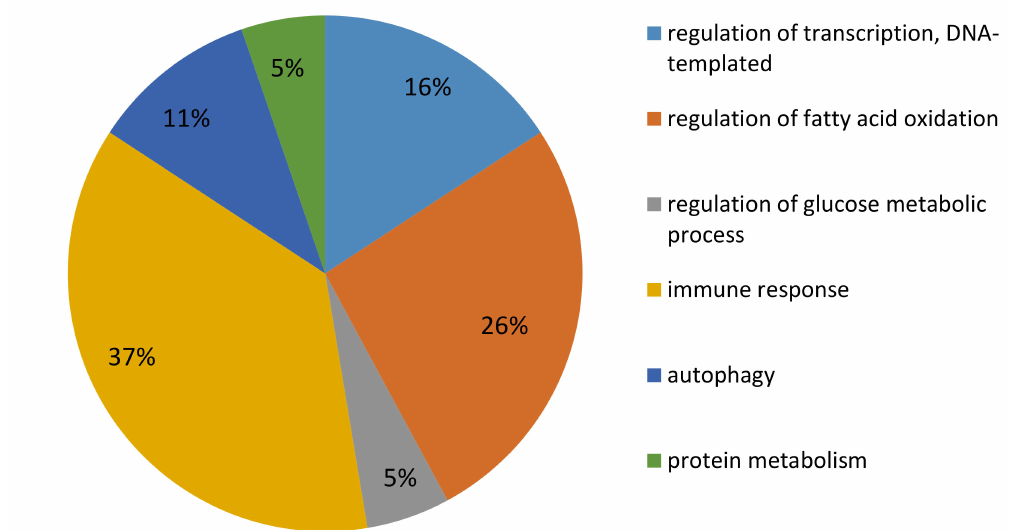
Figure 2. Main biological processes of differentially expressed genes in mammary glands (MG) of underfed (REST) versus control (CONT) early lactation cows during an acute inflammation identified by transcriptomic analysis. Each percentage was indicated for each biological processes. Bioinformatics analyses were performed using Panther and Pathway Studio ® software.